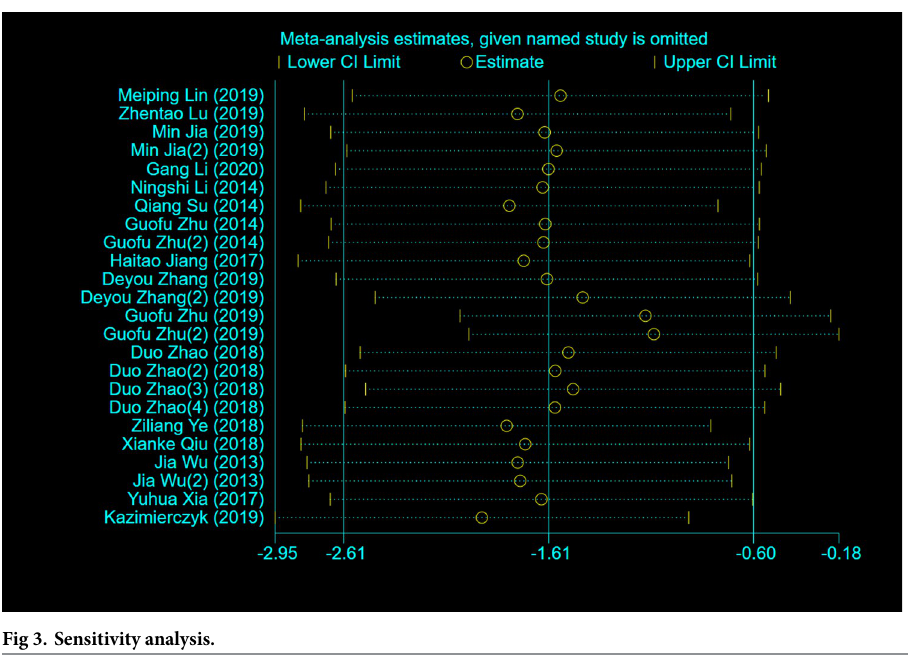
Fig 3. Sensitivity analysis.